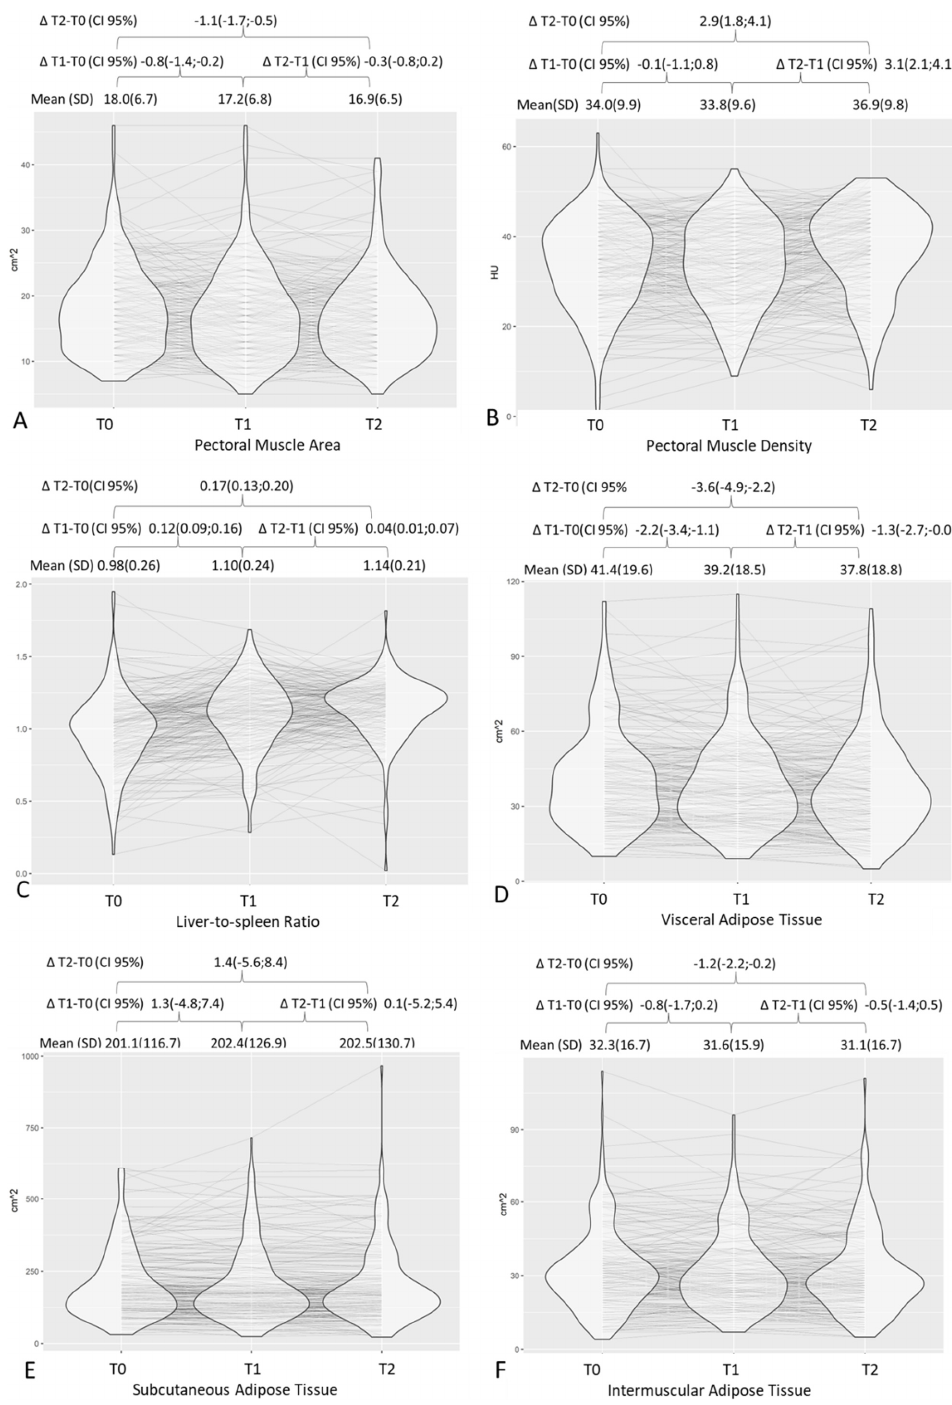
Figure 2. Distribution of chest CT body composition parameters at different time points with graphic representation of trajectories over time and respective mean values and deltas. T0, baseline; T1, 2–3 months after diagnosis; T2, 6–7 months after diagnosis. Graphs are for pectoral muscle area ( A ), pectoral muscle density ( B ), liver-to-spleen ratio ( C ), visceral adipose tissue ( D ), subcutaneous adipose tissue ( E ), and intermuscular adipose tissue ( F